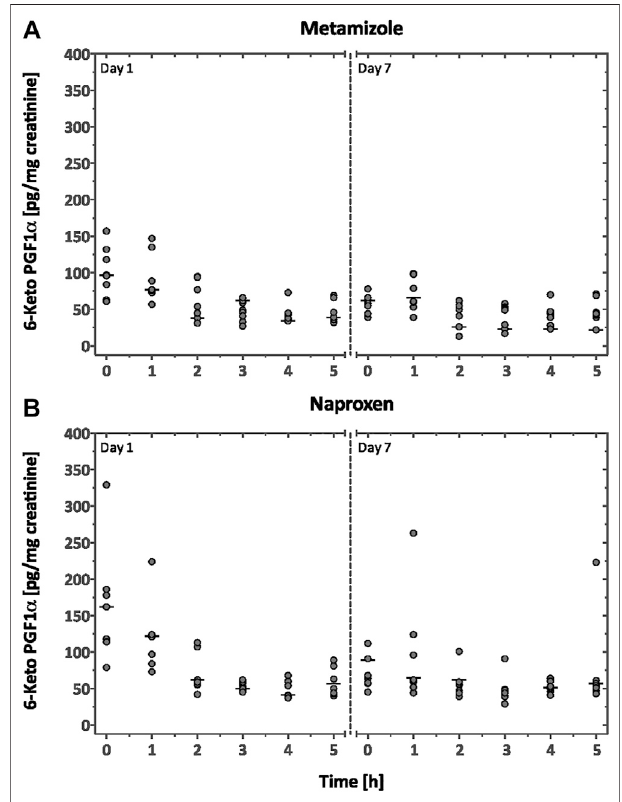
FIGURE 4 | Urinary 6-keto-PGF1 α excretion. Excretion of urinary 6- keto-PGF1 α measured after a single oral dose of 1,000 mg metamizole (A) or 500 mg naproxen (B) on day 1 and after multiple daily dosing on day 7. Data are presented as individual data ( fi lled circles) normalized to urinary creatinine content and median values (horizontal lines).